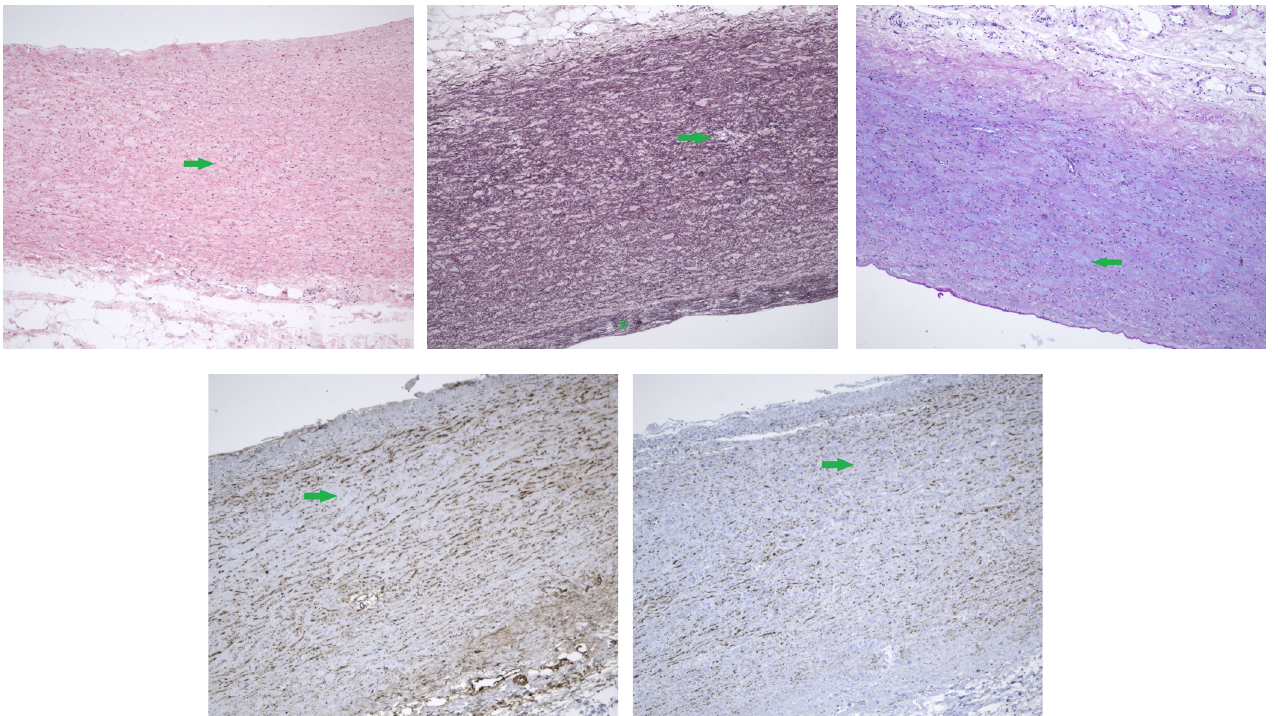
Fig. 4 - Photomicrographs of aortic wall. A) Marked reduction of cellular preservation showing shrunken and pyknotic nuclei (arrow), hematoxylin and eosin stain, magnification 100×; B) mild fragmentation elastic fibers (arrow) and mild intimal fibrosis (asterisk), Weigert’s resorcin fuchsin stain, magnification 100×; C) mild intralamellar mucoid extracellular matrix accumulations (arrow), Alcian blue/periodic acid-Schiff stain, magnification 100×; D) anti-vimentin immunohistochemical stain demonstrating marked reduction of mesenchymal cells (arrow), magnification 200×; E)